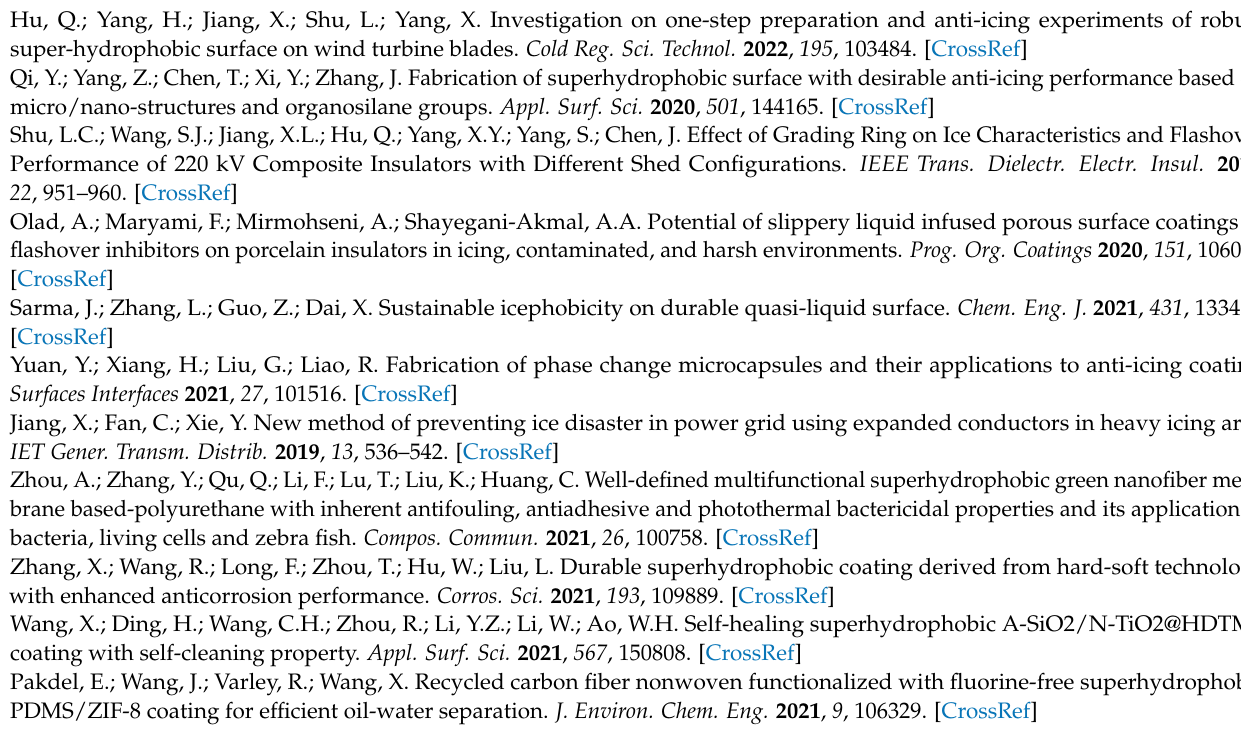
ferent PTFE mass fractions; Figure S2: FTIR spectra of coatings with 0% and 47.2% mass fraction; Figure S3: Water-droplet-bouncing performance values of glass and of the 0%, 15.2% and 34.9% mass fraction coatings at 25 ◦ C; Figure S4: Water-droplet-bouncing performance values of coatings with 47.2% and 58.8% mass fraction at 25 ◦ C; Figure S5: Water-droplet-bouncing performance values of glass and coatings with different mass fractions at − 10 ◦ C